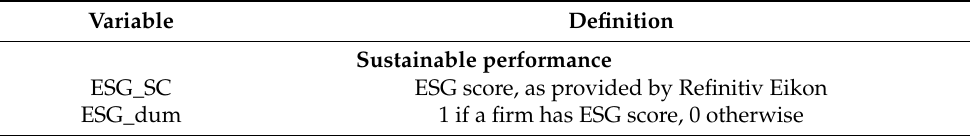
Table 2. Variables and their